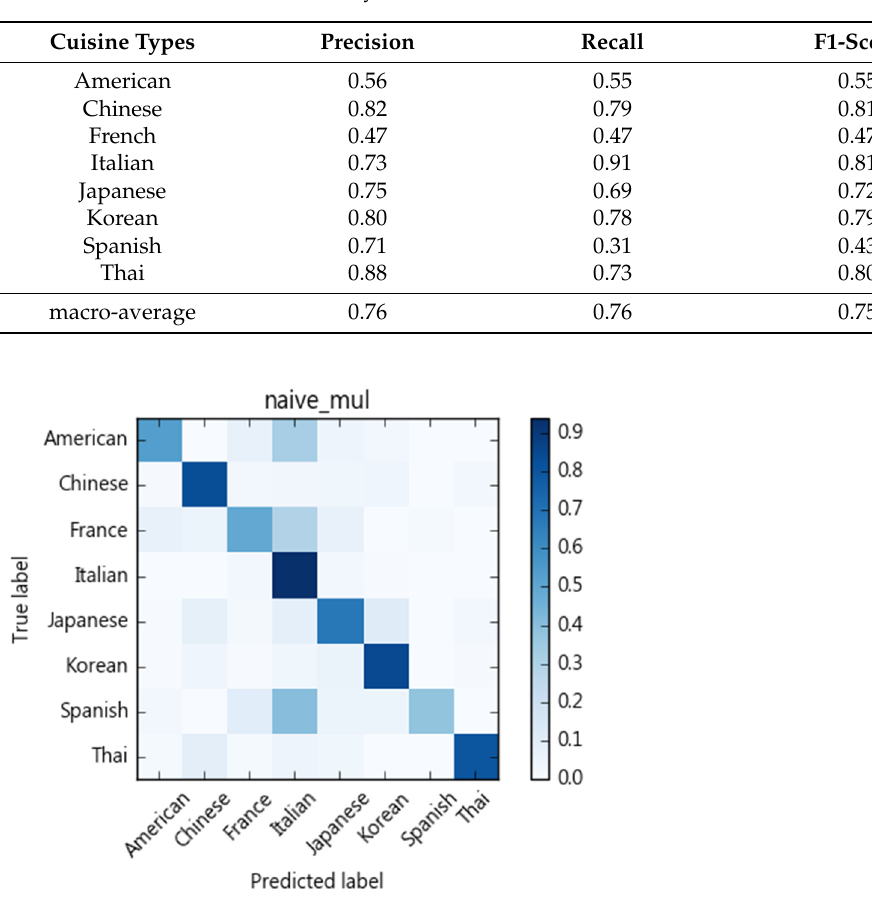
Figure 6. Confusion matrix of naïve Bayes classifier. The macro average of three metrics from all classifiers are compared in Figure